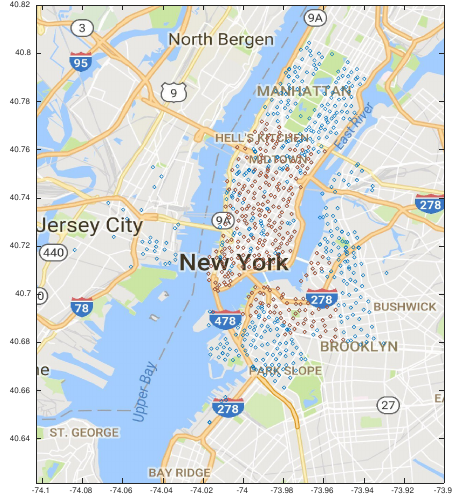
Figure 1. Map of the bike-sharing stations: red points identify the stations considered in our